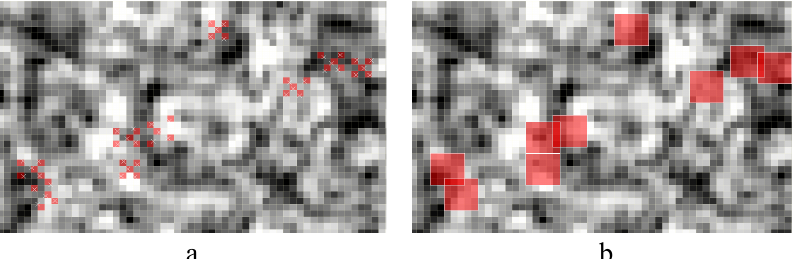
Figure 4. SNAP Toolbox snippets, of some sampling locations, illustrating the extraction of backscatter intensity from the 10 band combinations, example of VV backscatter in dB: ( a ) for 5 pixels masks at the DHP collection points. ( b ) for 25 pixels (50 m × 50 m) polygon masks encompassing sampled plots and corresponding DHP